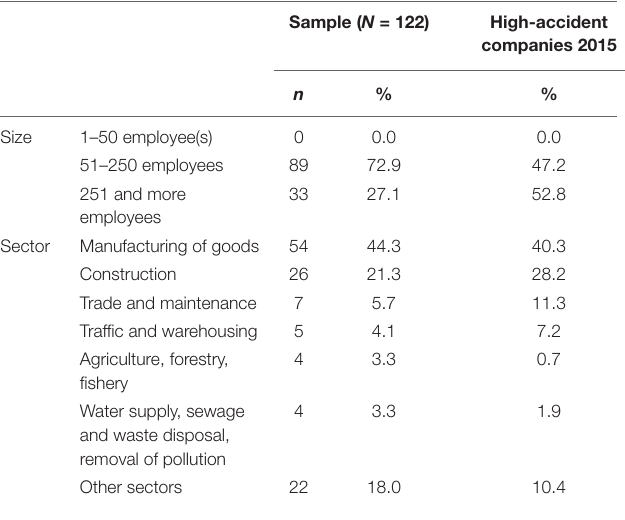
TABLE 2 | Description of companies’ sizes and